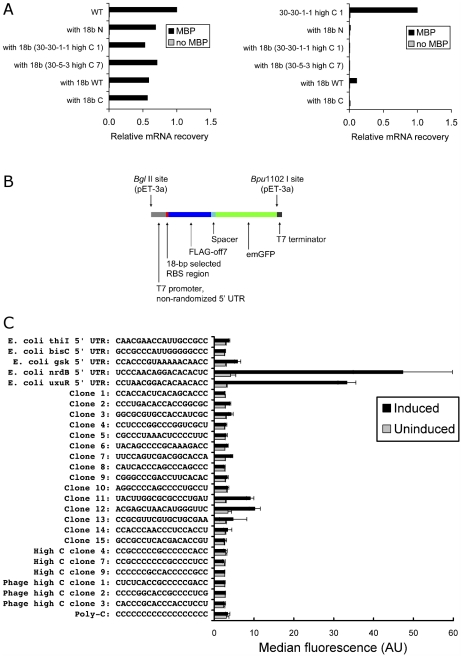

In vitro competition and in vivo expression.(A) WT and Clone 30-30-1-1 high C 1 were differentially affected by 400 µM 18-base ssDNA oligonucleotide competitors: random (N), clone 30-30-1-1 high C 1, a similar C-rich clone (30-5-3 high C 7), WT, and poly-C. MBP = maltose-binding protein. (B) Expression cassettes containing an RBS followed by FLAG-off7-emGFP were built by assembly PCR and cloned into pET-3a, which was used to transform BL21(DE3)pLysS. (C) Green fluorescence (excitation/emission: 487/509 nm) was quantified by flow cytometry after 4 h induction with 1 mM IPTG. The average median fluorescence of induced and uninduced clones is shown. Error bars represent standard deviation of at least three experiments. The first five sequences are the E. coli 5′ UTRs (18 bases before the start codon) having the most similarity to individual selected library members. They also happen to be highly C-rich for E. coli. Of these, only the E. coli nrdB 5′ UTR (UCCCAACAGGACACACUC) contains an SD motif (underlined). The next 15 sequences (“Clone 1” to “Clone 15”) are the most prevalent clones sequenced from the 30-5-3 selection scheme. The next six sequences are three of the most C-rich clones sequenced and three of the most C-rich 5′ UTRs present in phages from the EMBL-EBI database (Burkholderia phage KS14: HM461982; Mycobacterium phage Nigel: EU770221; and Synechococcus phage Syn5: EF372997, respectively). The final sequence is poly-C, which does not perform well. WT average median fluorescence (not shown) was extremely high (1417±178 AU induced, 15.2±15.6 AU uninduced).